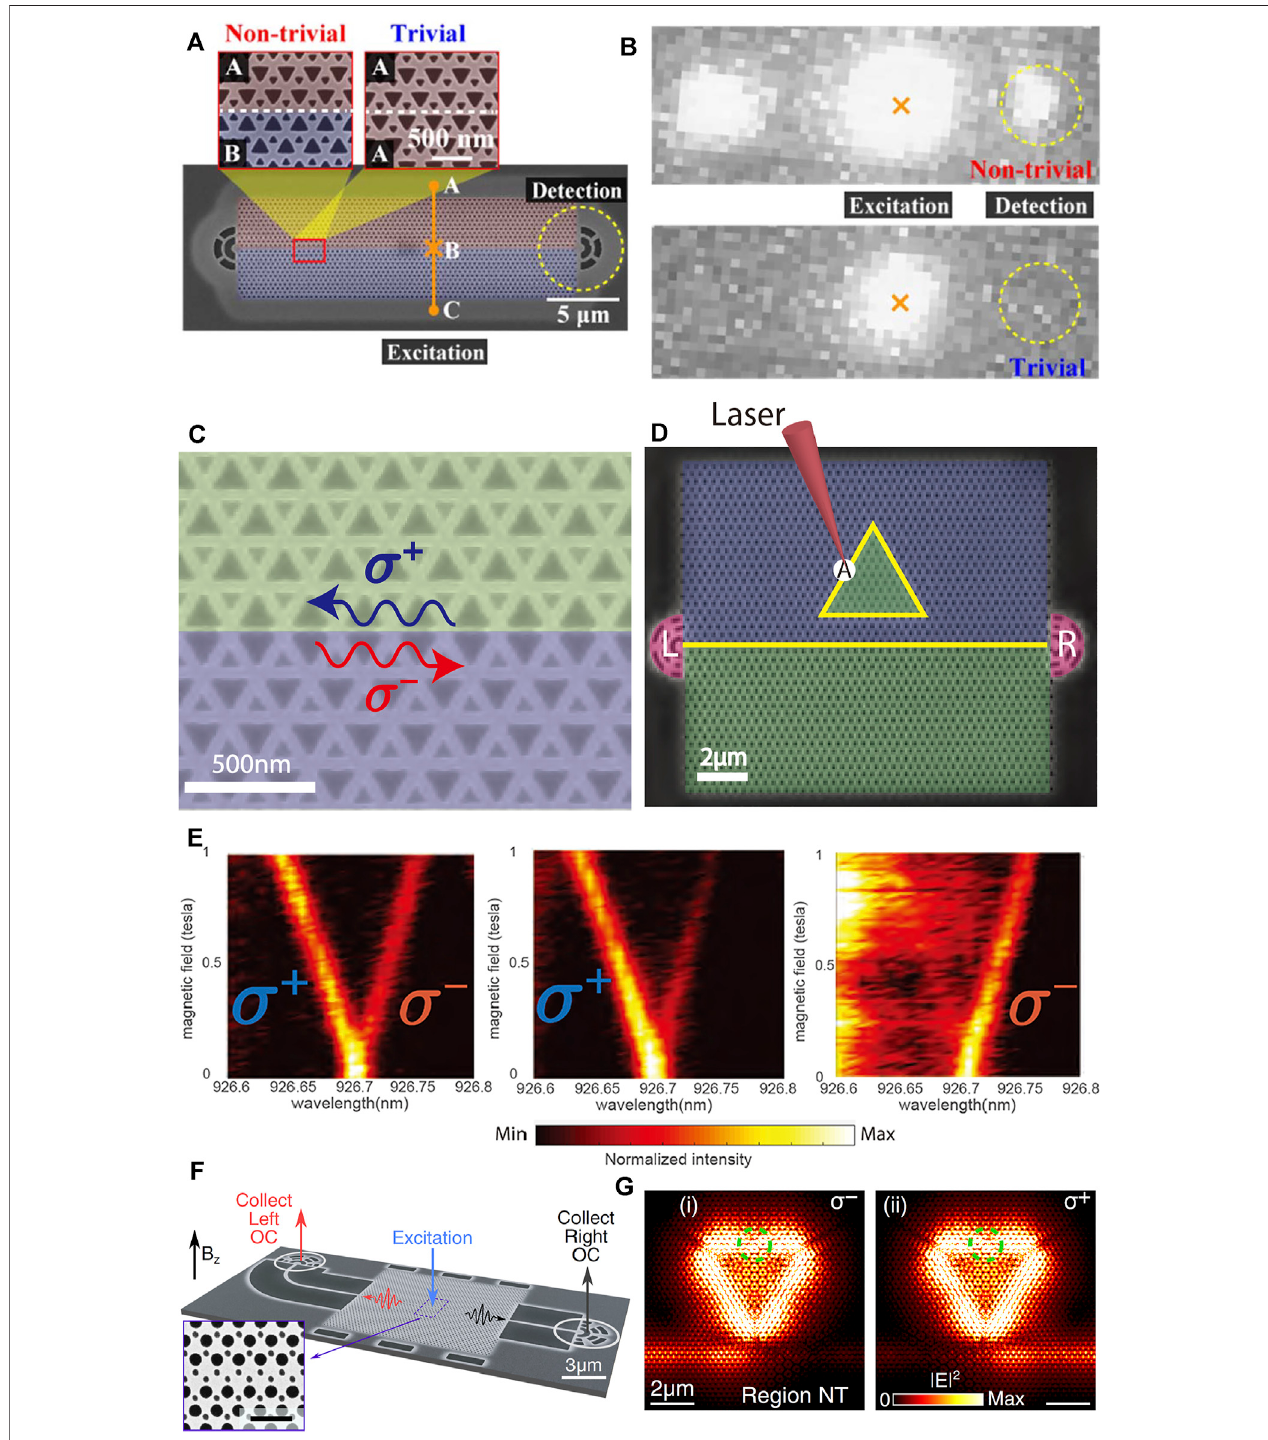
FIGURE 4 | (A) Schematic of a Z-shaped valley photonic crystal waveguide with two grating output couplers at the two ends [105]. (B) Measured photoluminescence images of non-trivial and trivial interfaces. (C) Schematic ofthe topological interface formed by two valleyphotonic crystalswith the same bulk band but different topology properties, supporting two various edge states with opposite chirality [106]. (D) Structural image of the topological ring resonator composed of a triangular loop and a straight waveguide terminated by two grating output couplers marked by “ L ” and “ R ” . The mark of “ A ” indicates the position of excitation. (E) Measured photoluminescence spectra from A position, left grating, and right grating, respectively. (F) Schematic of the topological ring resonator (RR) with triangular shape coupled to a straight waveguide (WG), terminated by two nanobeam waveguides and two grating output couplers [94]. (G) Calculated electric fi eld pro fi le of the topological ring resonator when excited by a dipole source with opposite circular polarization of σ - and σ +.